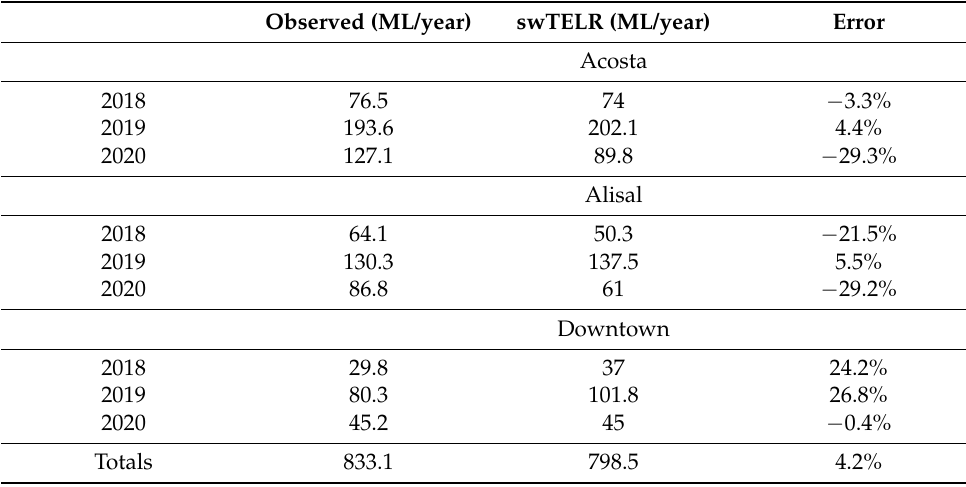
Table 3. Comparison of observed and modeled annual runoff for each catchment. Negative errors indicate runoff under prediction by swTELR.